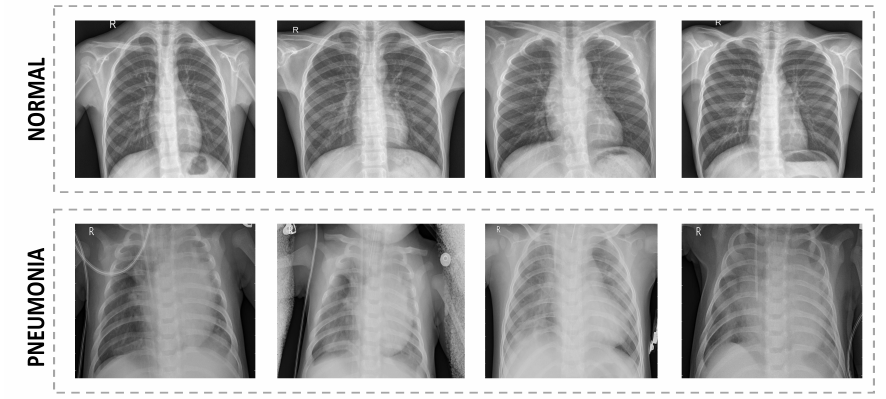
Figure 2. Samples of chest X-ray for pneumonia classification task from the selected database. The above row shows the normal images, and the bottom row shows the pneumonia